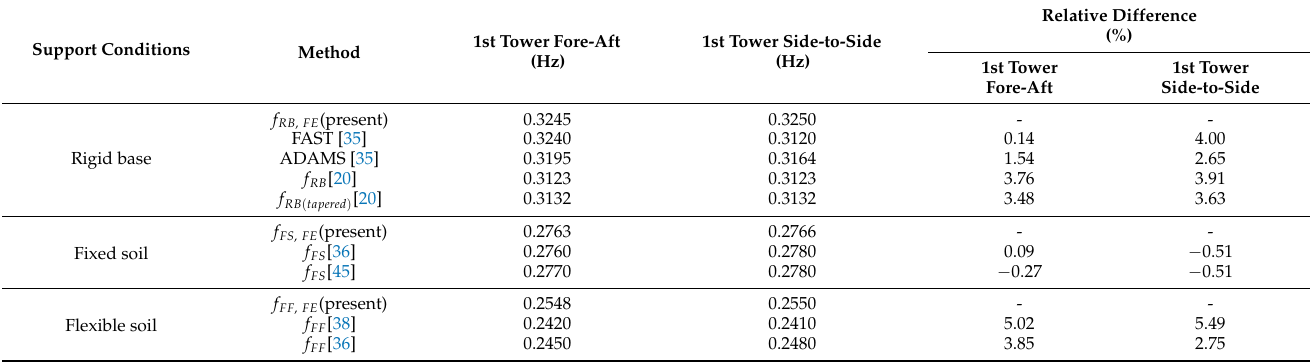
Table 5. Comparison of the simulation results of the FE model with the results of other studies of the NREL turbine model for the rigid base (RB), fixed soil (FS) and flexible soil (FF) condition.